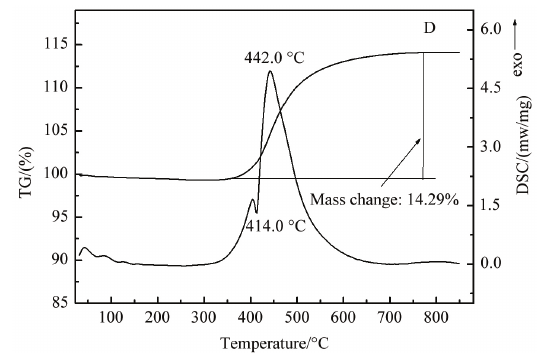
Figure 1. XRD patterns of ZnO powders obtained by oxidation of Zn nanoparticles at various temperatures. Figure 2. TG-DSC curve of Zn